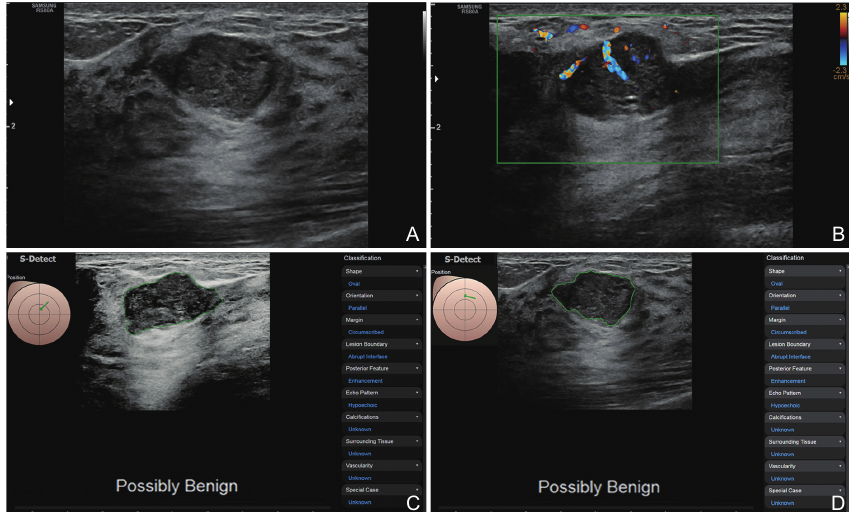
Figure 2 False-classified results in a 41-year-old woman with invasive ductal carcinoma when combining conventional US with CAD assessment based on method 1. (A) Grayscale US image revealed a 2.5-cm irregular microlobulated hypoechoic mass, which was classified as BI-RADS category 4a by experienced radiologists; (B) Tumor vascularity was not abundant on color Doppler ultrasound; (C-D) Deep learning-based CAD analyzed US features of mass with final assessment results of “possibly benign” on both transverse and longitudinal US images, leading to an incorrect downgrade to BI-RADS category 3 according to the combined method.